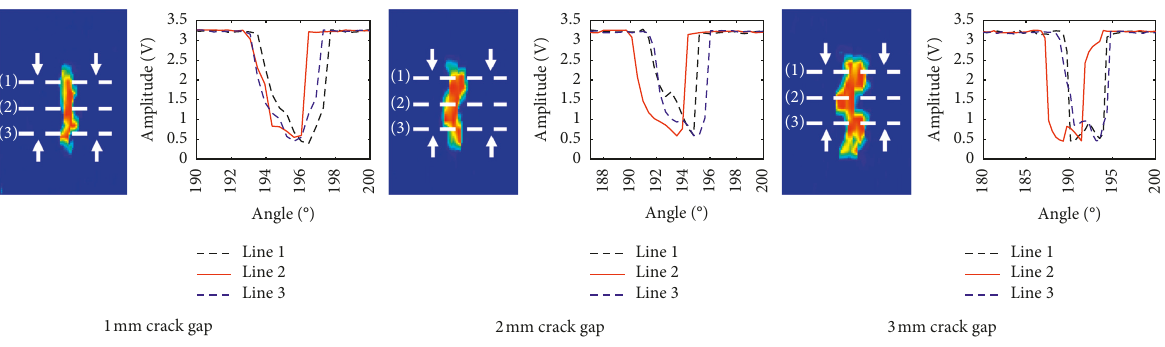
Figure 22: Inspection results for 7mm triple-type crack: C-scan (left) and cross section amplitude (right).